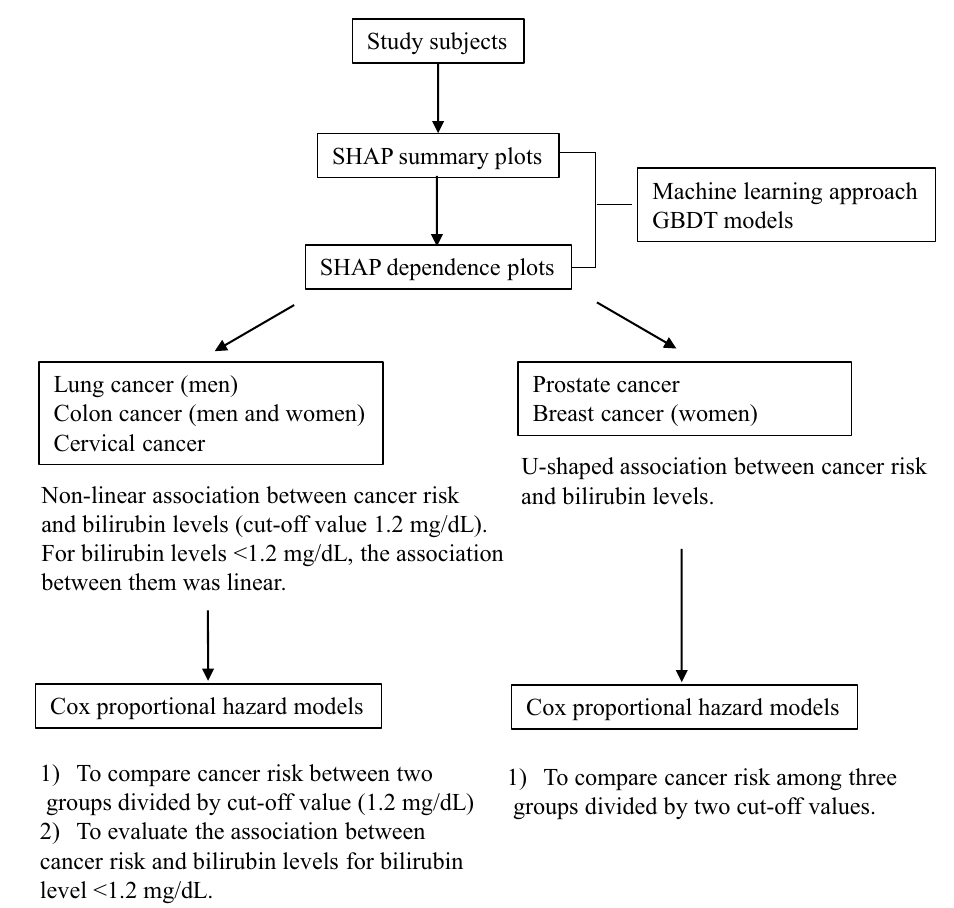
Figure 1. The roadmap for statistical analyses to evaluate the association between each cancer risk and serum bilirubin levels. GBDT model, gradient boosting decision tree model; SHAP summary plots, SHapley Additive exPlanations summary plots; SHAP dependence plots, SHapley Additive exPlanations summary